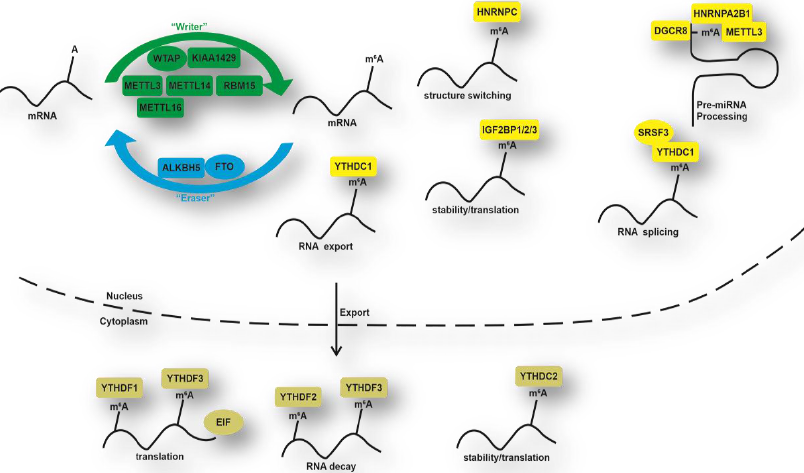
Figure 1. Summary of m 6 A modification machinery. N 6 -methyladenosine (M 6 A) is catalyzed by methylases, which serve as ‘writers’ containing methyltransferase-like 3 (METTL3), methyltransferase-like 14 (METTL14), wilms’ tumor 1-associating protein (WTAP), and a series of additional subunits. Fat mass and obesity-associated protein (FTO) and alkB homolog 5 (ALKBH5) serve as ‘erasers’ and exert a demethylation function. M 6 A reader proteins, such as YTH domain family 1/2/3 (YTHDF1/2/3), YTH domain-containing 1/2 (YTHDC1/2), heterogeneous nuclear ribonucleoprotein (HNRNP) family, and insulin-like growth factor 2 mRNA-binding protein (IGF2BP)